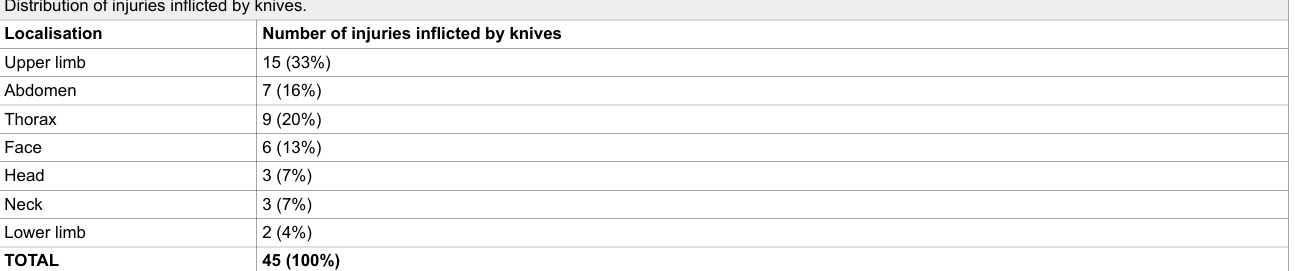
Table 1 Distribution of injuries inflicted by